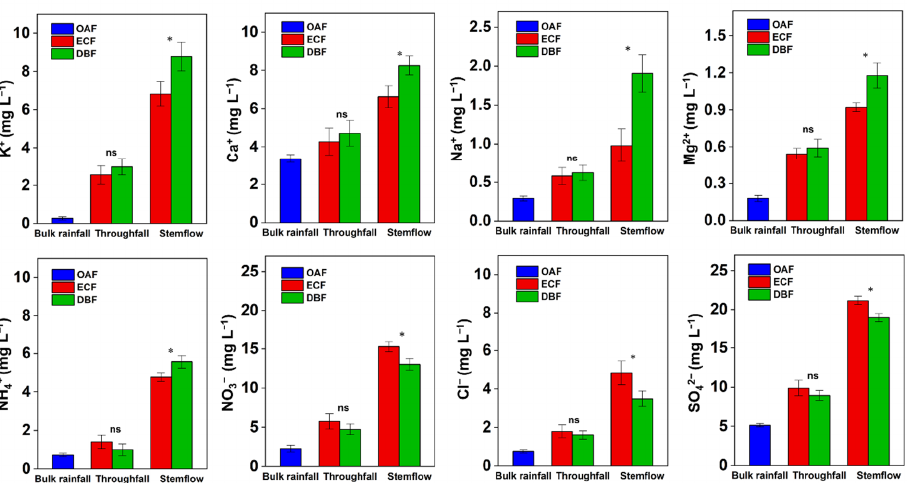
Figure 5. Annual volume-weighted average concentrations of major elements in the OAF, ECF, and DBF. The data from 23 rainfall collections in 2015. The vertical error bars are standard deviations; * indicates significant differences in element concentrations between the ECF stand and the DBF stand at the 0.05 level; ns, not significant in element concentra- tions between the ECF stand and the DBF stand at the 0.05 level. OAF: open area field; ECF: evergreen coniferous forest; DBF: deciduous broadleaved forest.